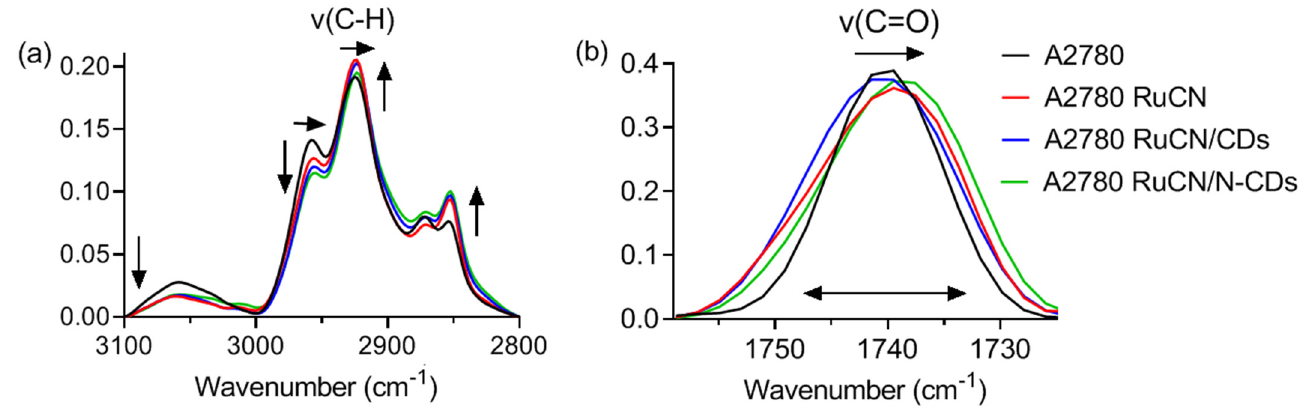
Figure 4. The lipid fingerprint area (( ν (C–H) ( a ) and ν (C=O) ( b )) of the untreated A2780 cancer cells (black line) and cells treated with RuCN complex (red line), RuCN/N-CDs (green line), and RuCN/CDs (blue line).